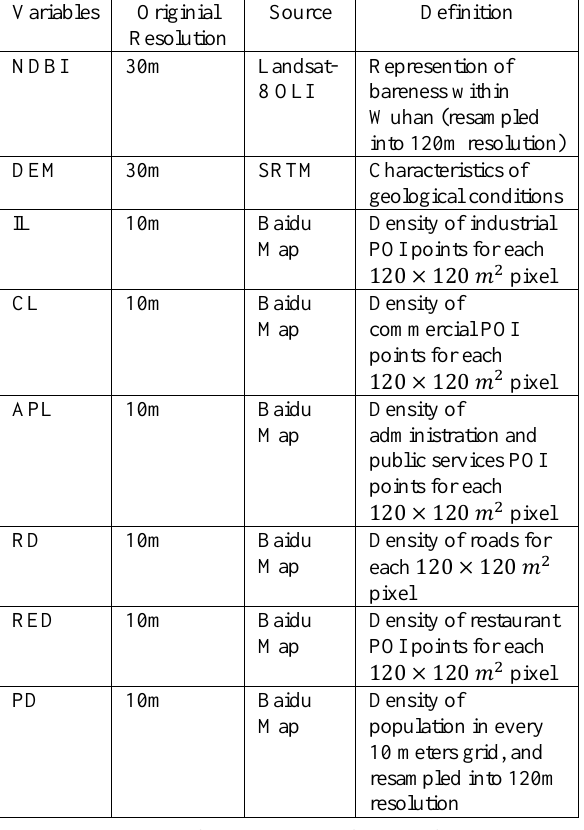
Table 2. Detailed information and definition of each variable All the POIs, roads shapefile and population density are collected using geospatial Big Data technique from Baidu Map (http://lbsyun.baidu.com). To be accordance with the resolution of PM2.5 concentration, natural factors are resampled into 120m resolution, and socioeconomic factors are calculated in 120 × 120 𝑚 2 pixel. The 24-hour average population density of Wuhan on February 17 th 2017 is shown in Figure 3.